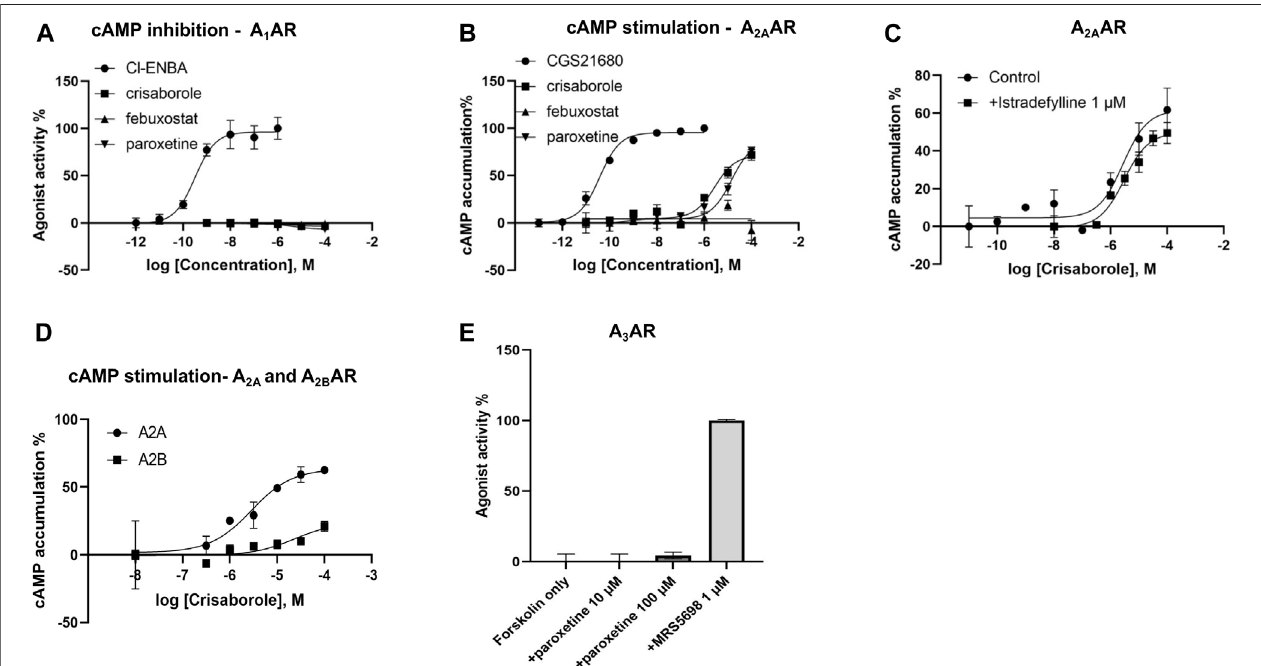
FIGURE2| FunctionaleffectsmeasuredintransfectedHEKcells. (A) DeterminationofcAMPinhibitioninA 1 AR-expressingcells,using N 6 -bicyclo[2.2.1]hept-2-yl- 5 ′ -chloro-5 ′ -deoxyadenosine (Cl-ENBA) as a reference full agonist (100% stimulation). (B) Determination of cAMP stimulation in A 2A AR-expressing cells, using 2-[p-(2- carboxyethyl)phenyl-ethylamino]-5 ′ - N -ethylcarboxamidoadenosine(CGS21680)asareferencefullagonist(100%stimulation). (C) Lackofantagonism,byanorthosteric agonististradefylline, ofthecrisaborole-inducedcAMPstimulationinA 2A AR-expressingcells.A 2A activationbycrisaboroleintheabsenceofantagonistshowedan EC 50 = 2.78 µM, and in the presence of istradefylline EC 50 = 2.99 µM. (D) Comparison of cAMP stimulation by crisaborole in A 2A - and A 2B AR-expressing cells, using NECA as a reference full agonist (100% stimulation). (E) Lack of agonist effect of paroxetine in A 3 AR-expressing cells, in comparison to (1S,2R,3S,4R,5S)-4-(6-((3- chlorobenzyl)amino)-2-((3,4-di fl uorophenyl)ethynyl)-9H-purin-9-yl)-2,3-dihydroxy-N-methylbicyclo [3.1.0]hexane-1-carboxamide (MRS5698) as a reference full agonist (100%